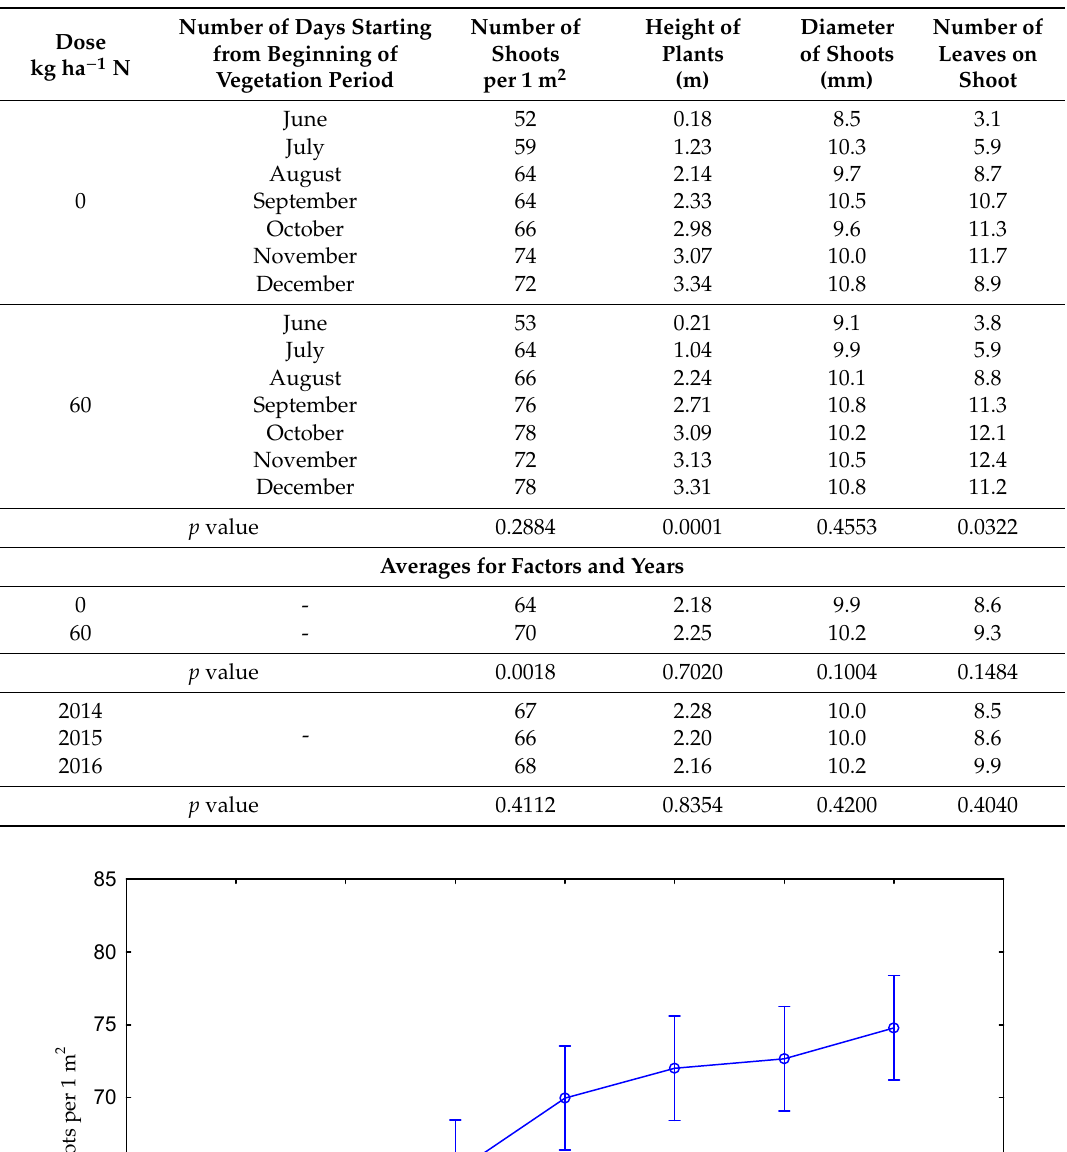
Table 4. Morphological features of Miscanthus × giganteus (average for years 2014–2016). Number of Days Starting Dose from Beginning of Shoots kg ha − 1 N Vegetation Period